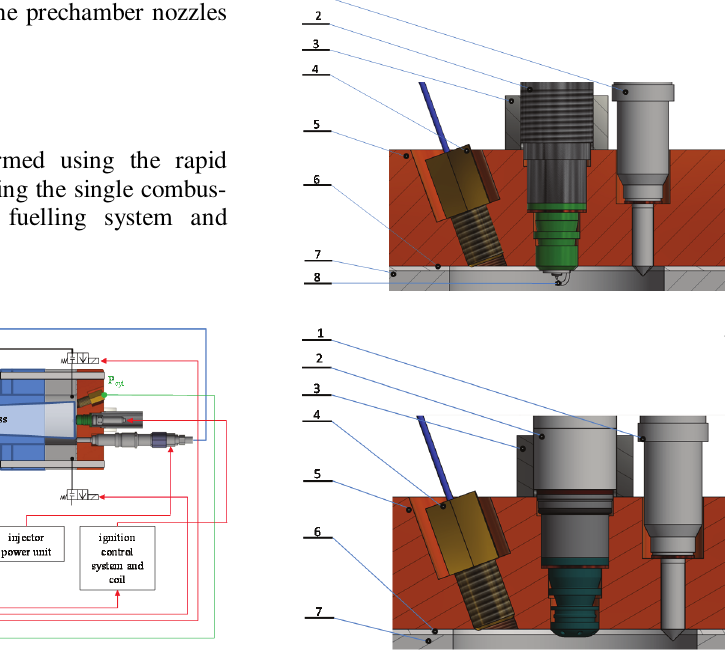
Fig. 2. SI (a) and TJI (b) assembled in the RCM